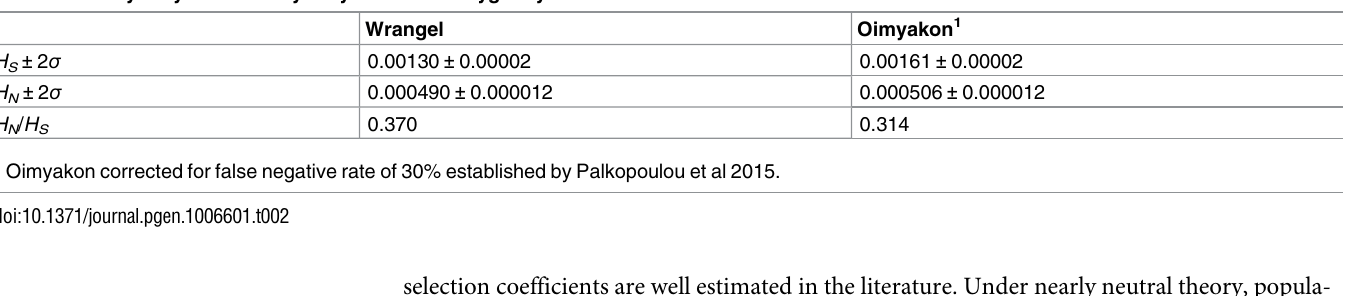
Table 2. Non-synonymous and synonymous